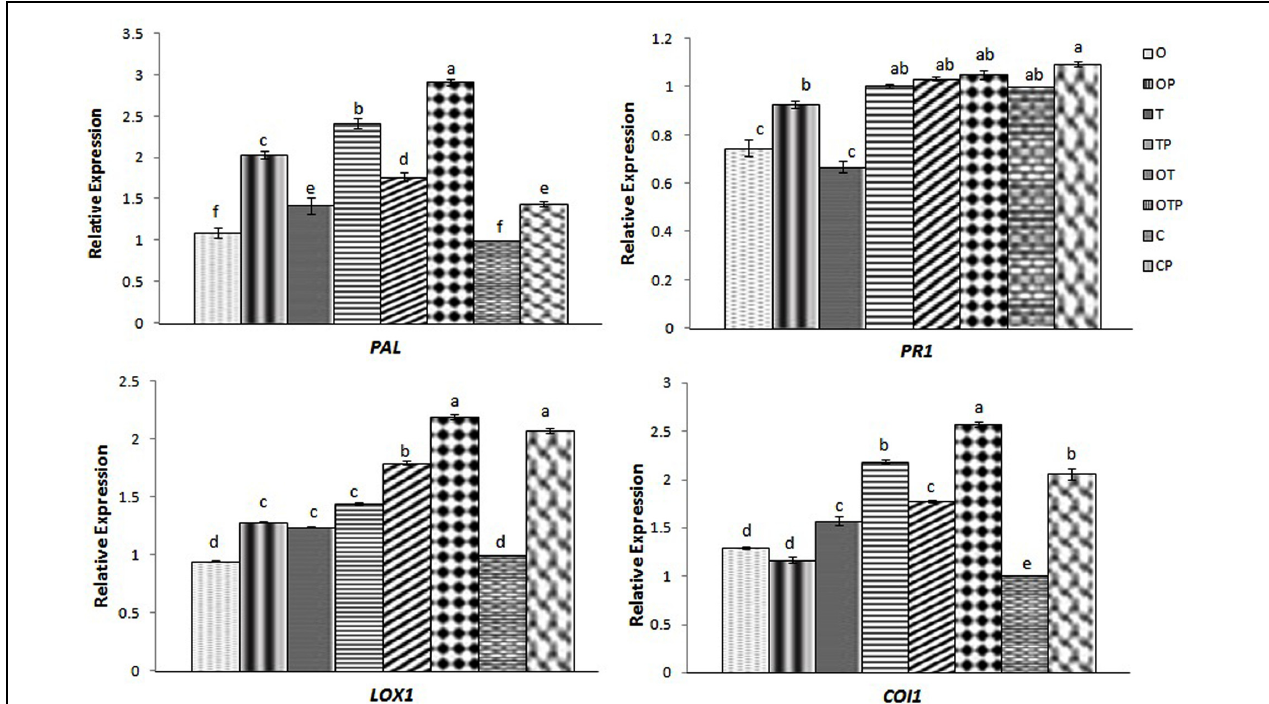
FIGURE 2 | Relative transcript accumulation patterns of two key genes representing JA ( LOX1 and COI1 ) and SA ( PAL and PR1 ) -mediated defense responses in pea leaves during challenge by the biotroph fungal pathogen Erysiphe as analyzed through quantitative real time-PCR in different treatments after 24 h of pathogen ( E. pisi ) challenge: O- P. fluorescens OKC; OP- OKC treated and pathogen challenged; T - T. asperellum T42; TP- T42 treated and pathogen challenged; OT- combination of OKC and T42; OTP- OKC and T42 treated and pathogen challenged; P- Pathogen challenged and C- OKC and T42 non-treated and pathogen unchallenged control. The qRT-PCR data were normalized with mean CT value of the endogenous gene ubiquitin and fold accumulation of transcripts was compared by using the mean of the CT values of the three biological replicates with treatment C (control). Error bars represent SD from means of three measurements. Different superscript letters indicate data significantly different from the other treatments ( P ≤ 0.05; Duncan’s multiple range test).